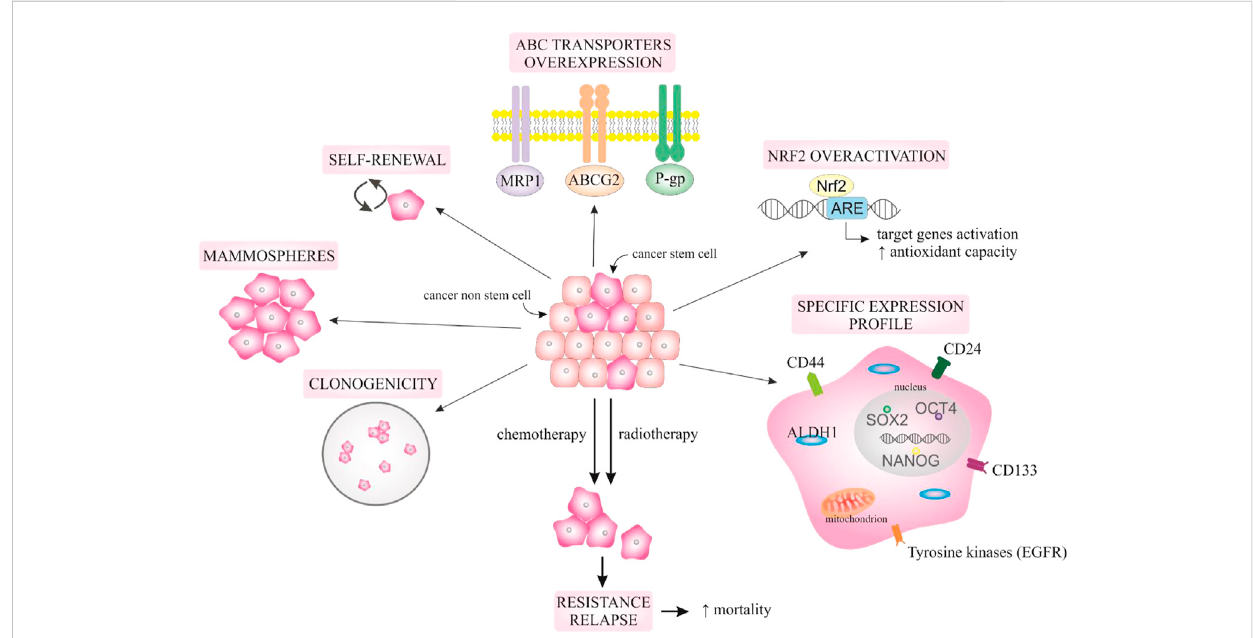
Selected BCSCs characteristics. Explanatory notes: BCSCs represent a sub-population of cancer cells that are de fi ned by multiple characteristics including self-renewal capability, mammosphere formation, and clonogenicity. BCSCs are associated with aberrant expression of speci fi c signalling molecules or aberrant activation of cell signalling pathways, including overexpression ofABC transporters (MRP1, ABCG2, P-gp responsible for the ef fl ux of the drug outside the cell, overactivation of Nrf2 that increases antioxidant defence of cells, and overexpression of other markers such as